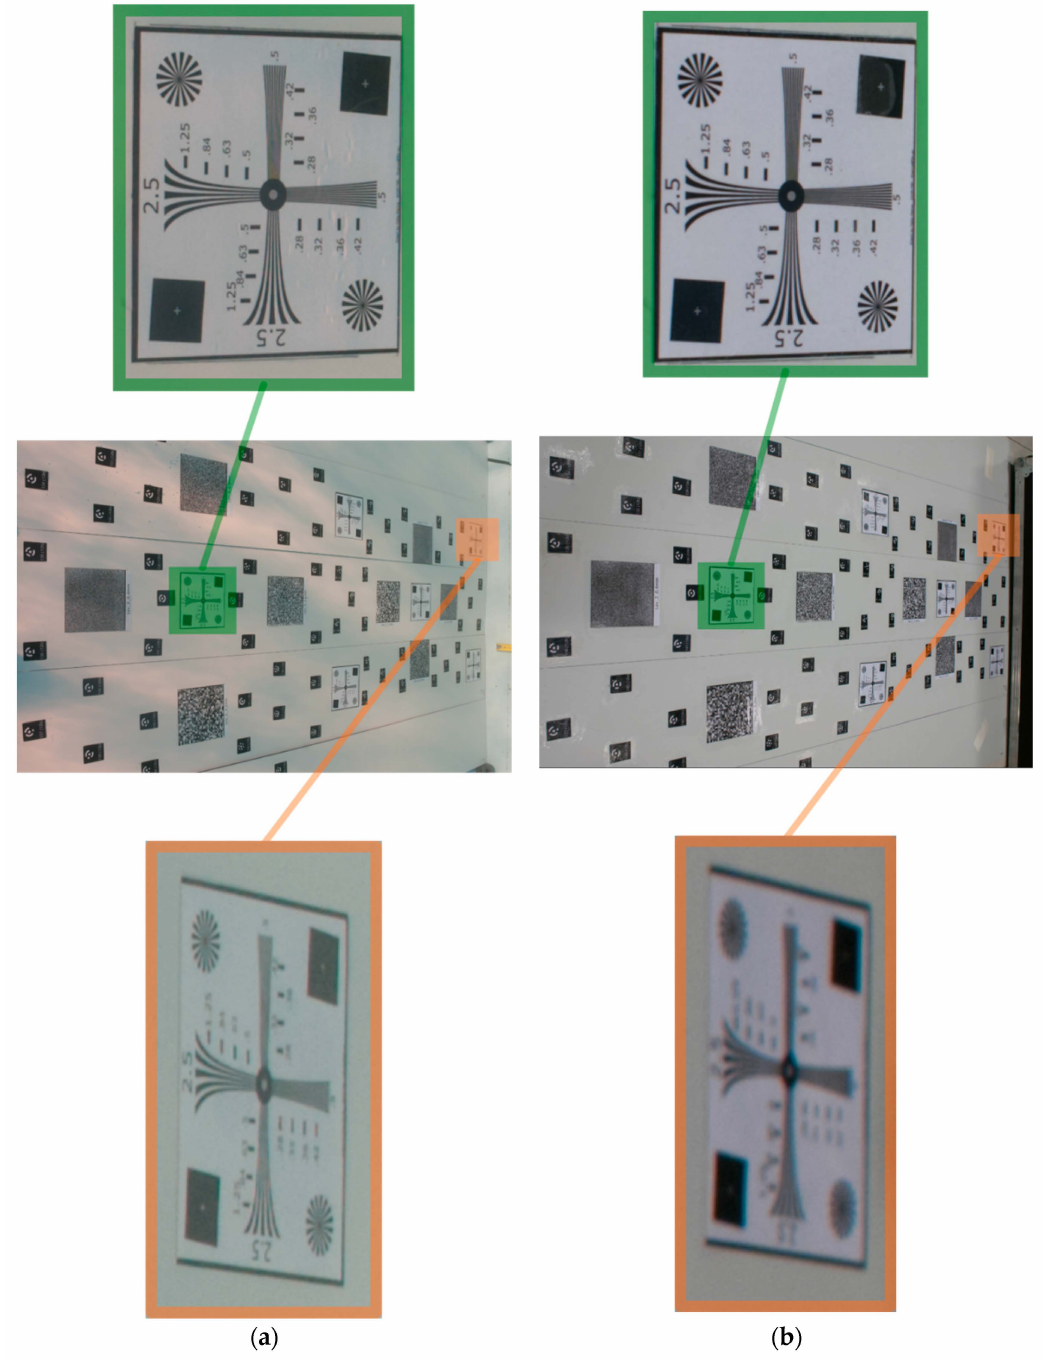
Figure 16. DOF variation between two pictures taken from very similar positions ( a ) underwater and ( b ) in